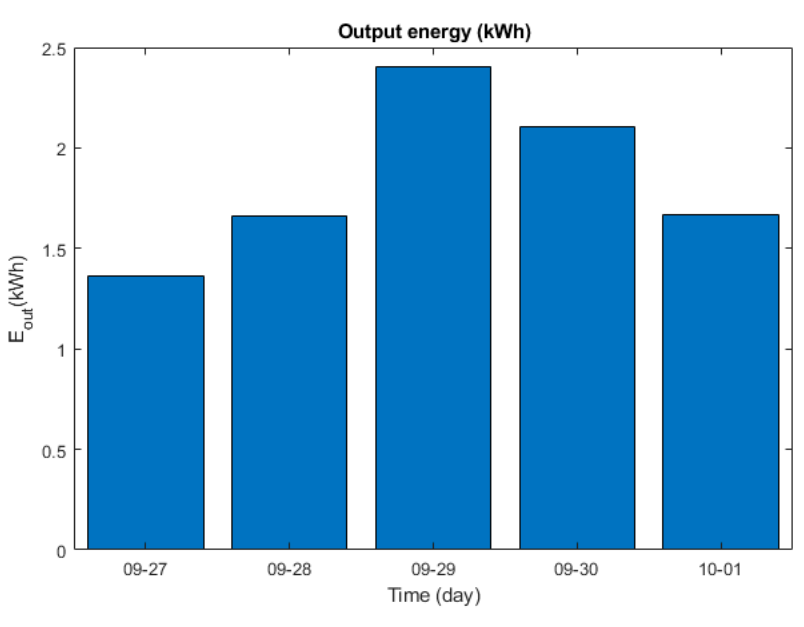
Figure 11. Energy generated (E OUT ).